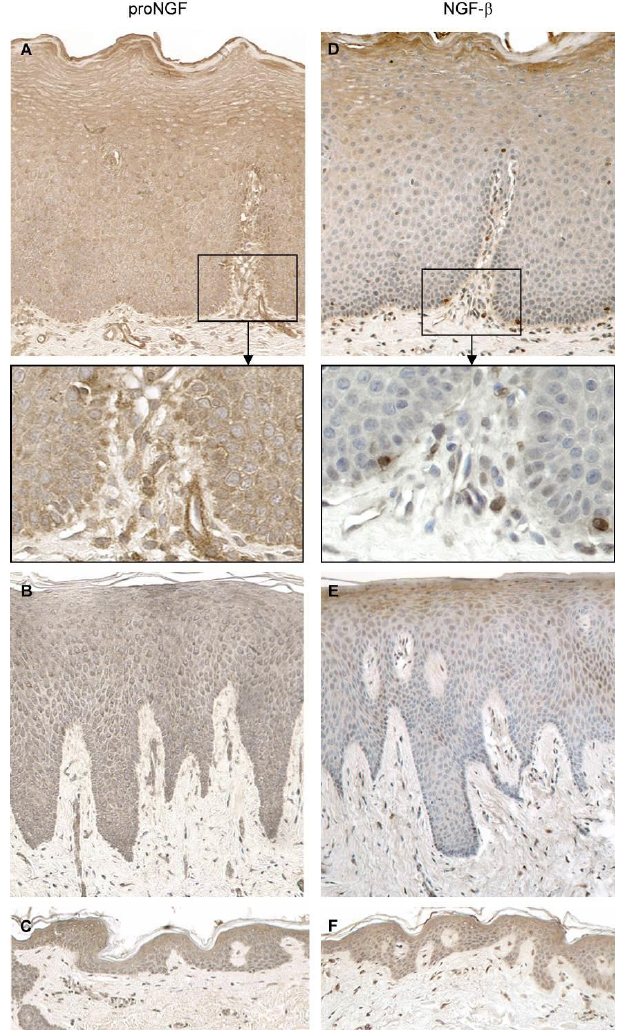
Figure 4. Immunohistological staining for pro-nerve growth factor (pro-NGF) ( A – C ) and NGF ( D – F ) in the epithelium of normal oral mucosa ( A , D ), gingiva ( B , E ), and skin ( C , F ). Original magnification, 20 ×. With permission from ref. [14].